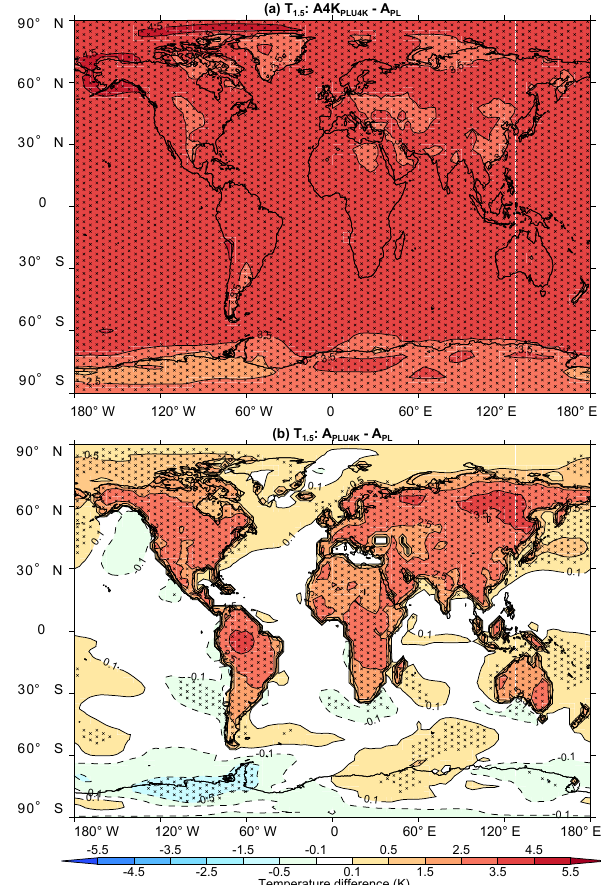
Figure 5. Differences in surface air temperature (TAS, K) for (a) A4K PLU4K minus A PL and (b) A PLU4K minus A PL . The points labelled with an “x” indicate the differences are statistically signifi- cant using Student’s t test ( p ≤ 0 .